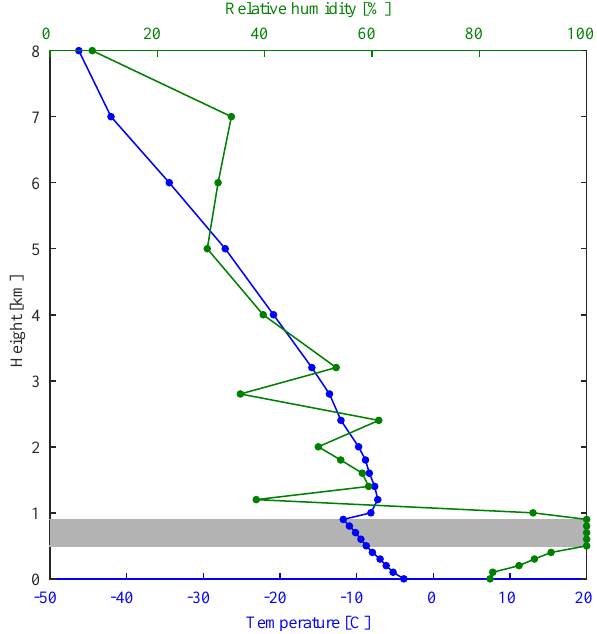
Figure 4. Example profile of temperature (blue) and relative hu- midity (green) from the surface to 8km. The cloud (gray shading) is placed between 0.5 and 0.9km, encompassing four model atmo- spheric layers. The temperature profile exhibits a cloud top inver- sion. Figure 5. Distributions of macrophysical properties for the base set